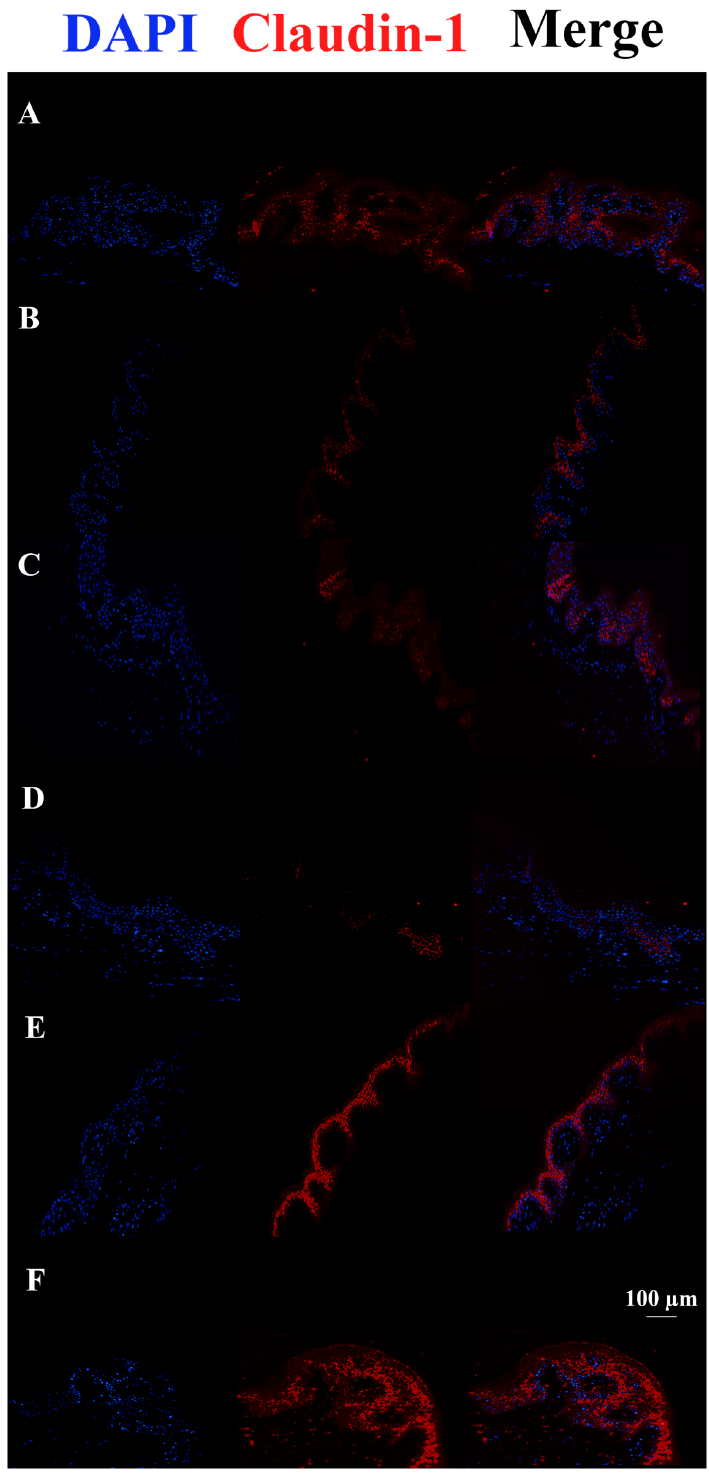
Figure 4. Claudin-1 immunofluorescence on animal explant sections infected with S. aureus ATCC29213 live bacteria (20 × magnification). DAPI channel on the left side (461 nm blue); Anti- Claudin-1 1 antibody Alexa568-conjugated in the middle; images are shown on the right. Lane description. ( A ) Not infected tissues; ( B ) not treated infected tissues; ( C ) c40 pre-incubated infected tissues; ( D ) HAc40 pre-incubated infected tissues; ( E ) c40 co-incubated infected tissues; ( F ) Hac40 co-incubated infected tissues. The Claudin-1 signal is stronger in tissues treated with c40 and Hac40 than in infected tissues alone. Scale bar 100 µm.